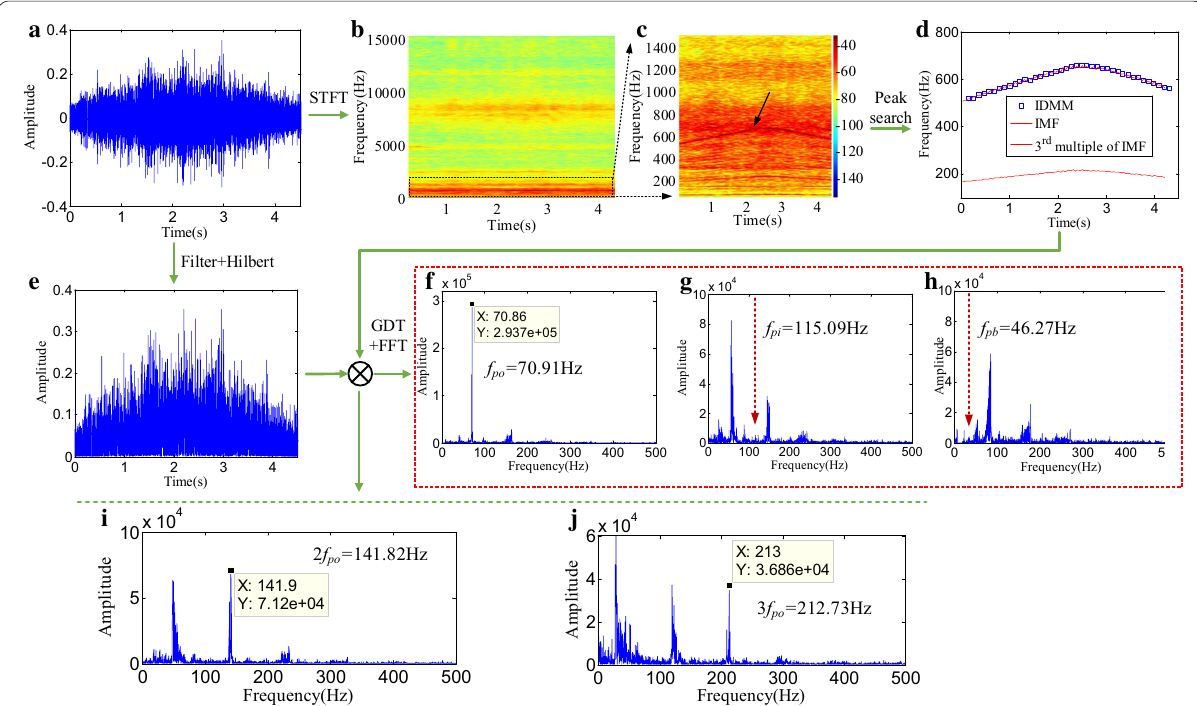
Figure 9 Analysis results of outer race fault signal: a raw signal, b TFR of raw signal, c partial enlargement of TFR, d extracted IDMM, e envelope of filtered signal; spectra of demodulated signals with different PFs: f s o ( t ), g s i ( t ), h s b ( t ), i 2 s o ( t ), j 3 s o ( t )